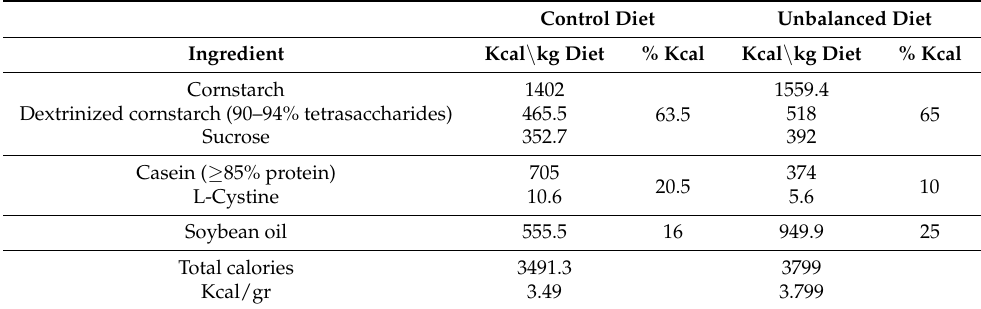
Table 2. Caloric composition of the experimental diets. Values are presented as calories per weight with added